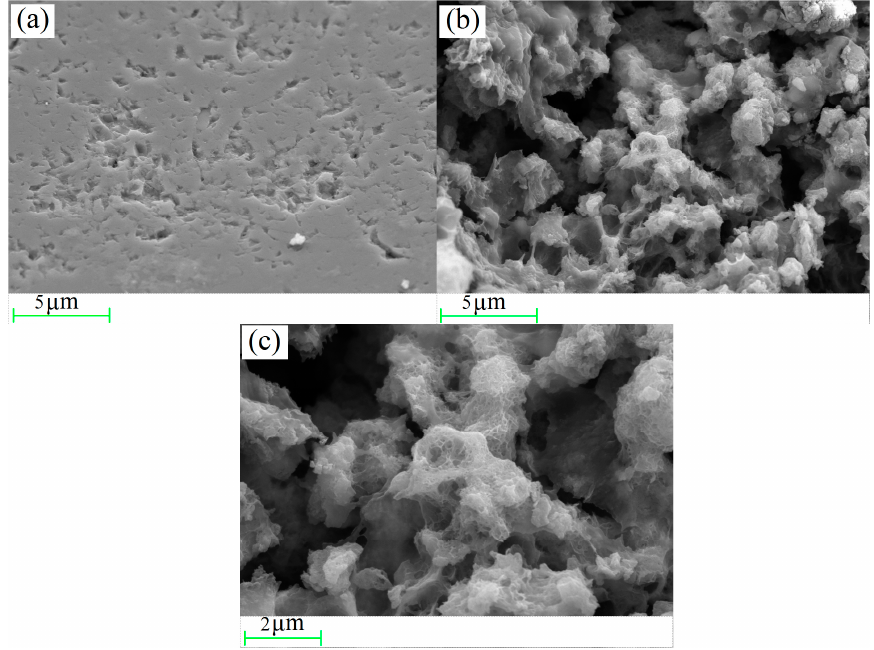
Figure 7. SEM images of ( a ) normal quartz sand magnified 5000 times, ( b ) MeOx magnified 5000 times, and ( c ) MeOx magnified 10,000 times.